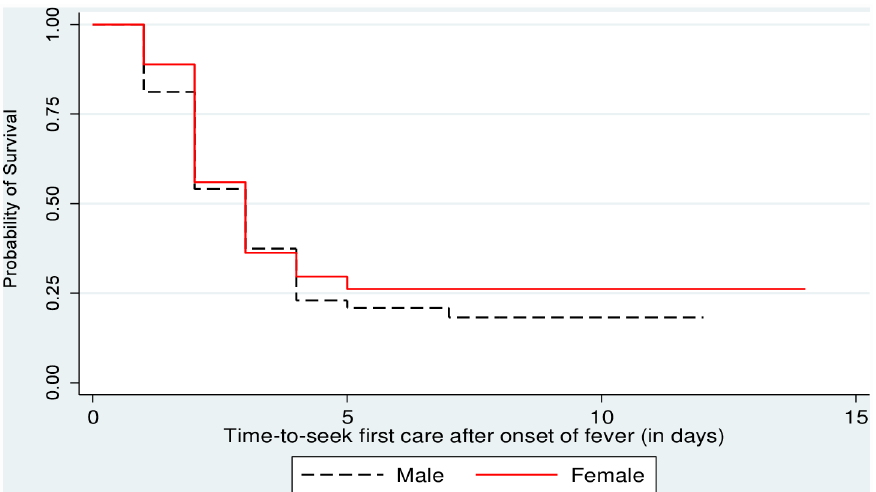
Fig 2. Kaplan-Meier Survival function for time-to-seek first care after onset of fever by sex, Jimma, Jan 2014. As indicated in the figure, females had longer survival time to seek first care after onset of fever although the difference was not statistically significant (log Rank X 2 = 0.667; P = 0.414). The mean survival time was 4.3 (Std Err = 0.5, 95%CI: 3.2 – 5.4) and 5.4 (Std Err = 0.6, 95%CI: 4.2 – 6.8) days for males and females, respectively. The overall estimated mean survival time was 5.1 (Std Err = 0.5, 95% CI: 4.2 –